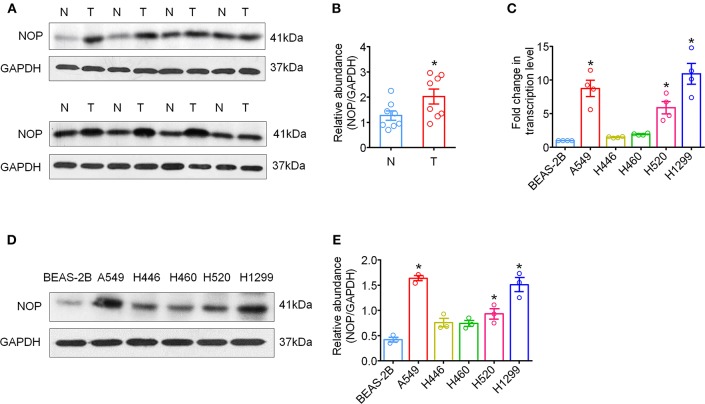
High expression levels of NOP in fresh tumor tissues and human NSCLC cell lines. (A) The global proteins of eight surgically removed tumor tissues (T) and the adjacent normal lung tissues (N) were extracted and the expression of NOP was assayed via western-blot, with GAPDH as an internal control. (B) Quantification of NOP expression via western-blot from fresh tumor tissues. *P < 0.05 from paired t-test. (C) mRNA expression of NOP in human bronchial epithelial cell line and NSCLC cell lines with different histology. *P < 0.05 compared with BEAS-2B from one-way ANOVA with Bonferroni's multiple comparisons test. (D) NOP expression in human bronchial epithelial cell line and NSCLC cell lines by western blot. (E) Quantification of NOP expression via western-blot from cell lines. *P < 0.05 compared with BEAS-2B from one-way ANOVA with Bonferroni's multiple comparisons test.